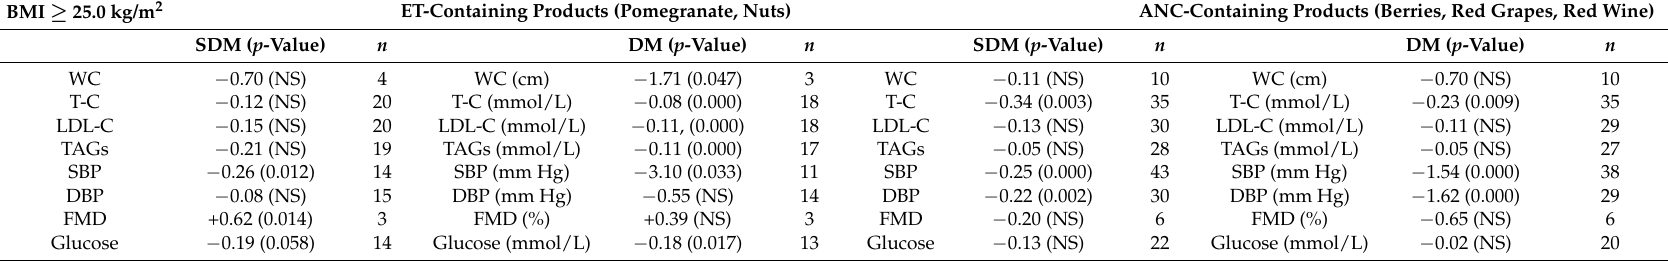
Significant: p -value 0.05; Marginally Significant (0.05 ≤ p -value 0.1). WC: Waist Circumference; T-C: Total Cholesterol; LDL-C: Low Density Lipoprotein Cholesterol; TAGs: Triglycerides; SBP: Systolic Blood Pressure; DBP: Diastolic Blood Pressure; FMD: Flow Mediated Dilation; n : total number of studies included in the analysis; SDM: standardized difference in